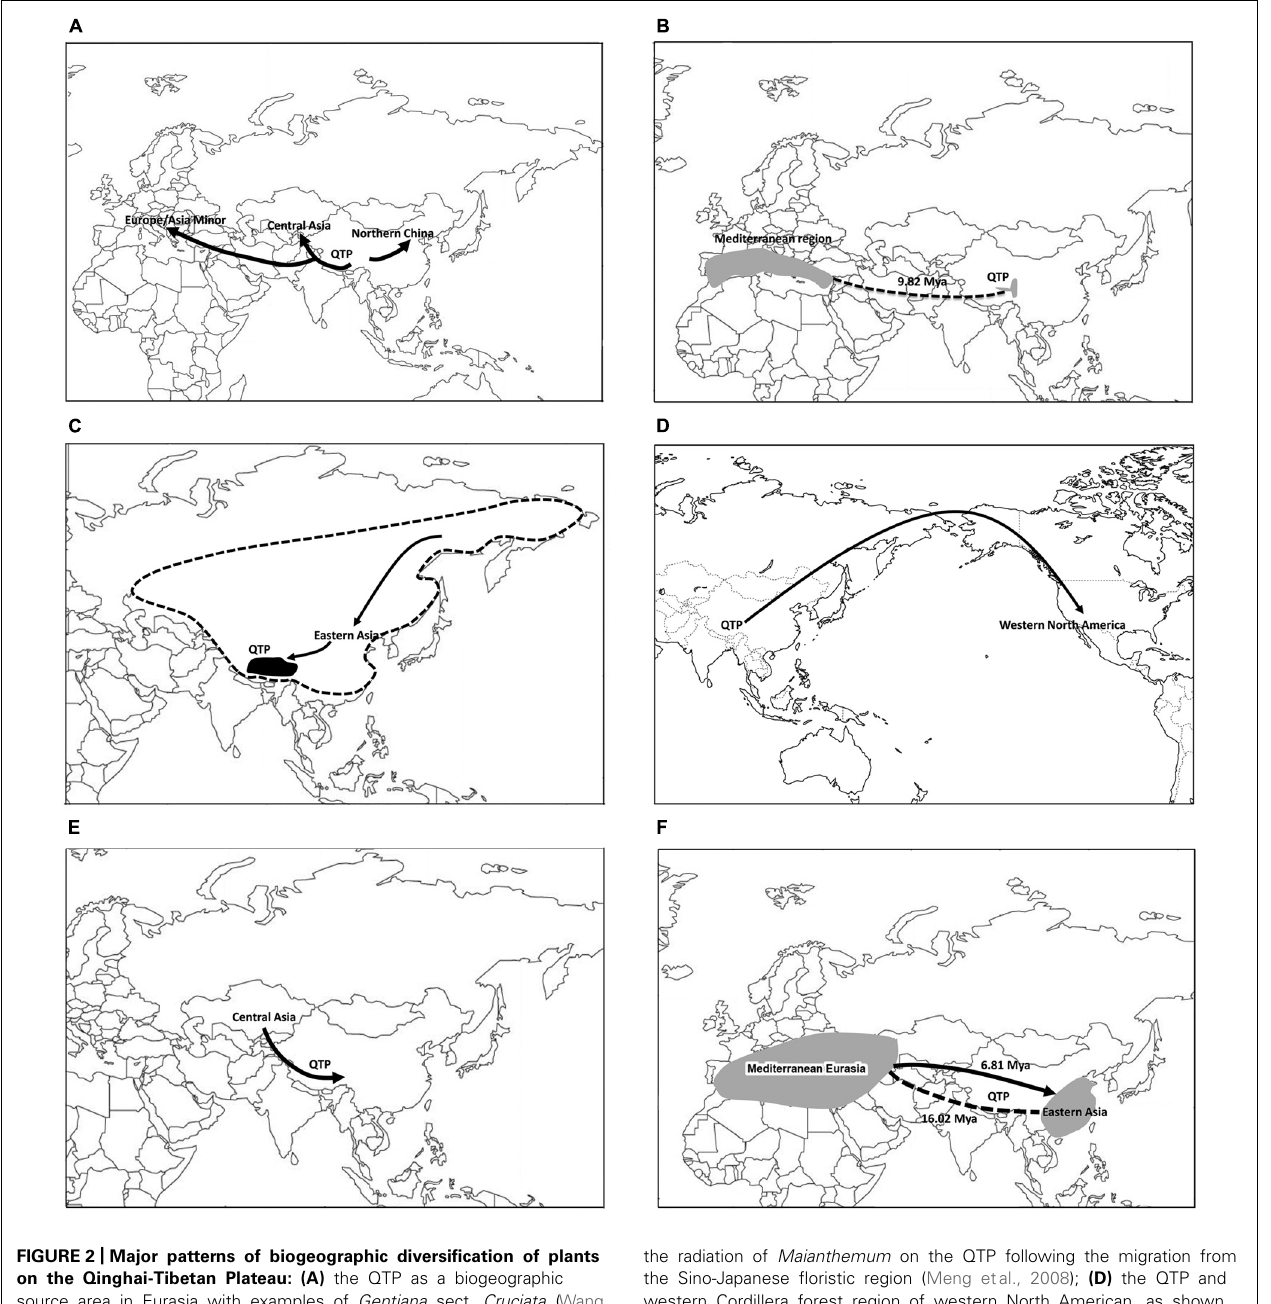
FIGURE 2 | Major patterns of biogeographic diversification of plants on the Qinghai-Tibetan Plateau: (A) the QTP as a biogeographic source area in Eurasia with examples of Gentiana sect. Cruciata (Wang etal., 2004) and Hippophae rhamnoides (Jia etal., 2012); (B) close biogeographic connections of the QTP with Mediterranean Eurasia, as exemplified by Mandragora (Tu etal., 2010); (C) Hengduan–Himalayan forest regions of the QTP showing close biogeographic relationships with Arcto-Tertiary floristic elements in eastern Asia, as exemplified by